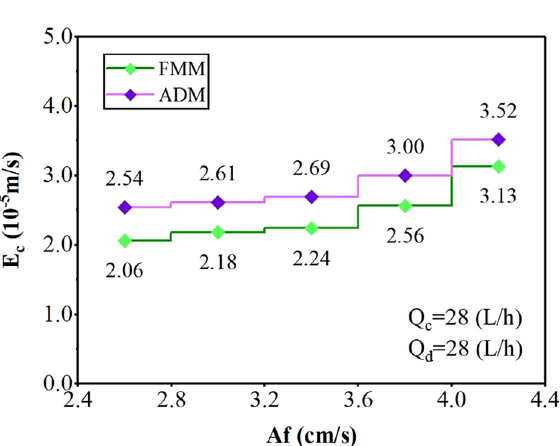
Figure 7. The effect of pulsation intensity on the continuous phase axial dispersion